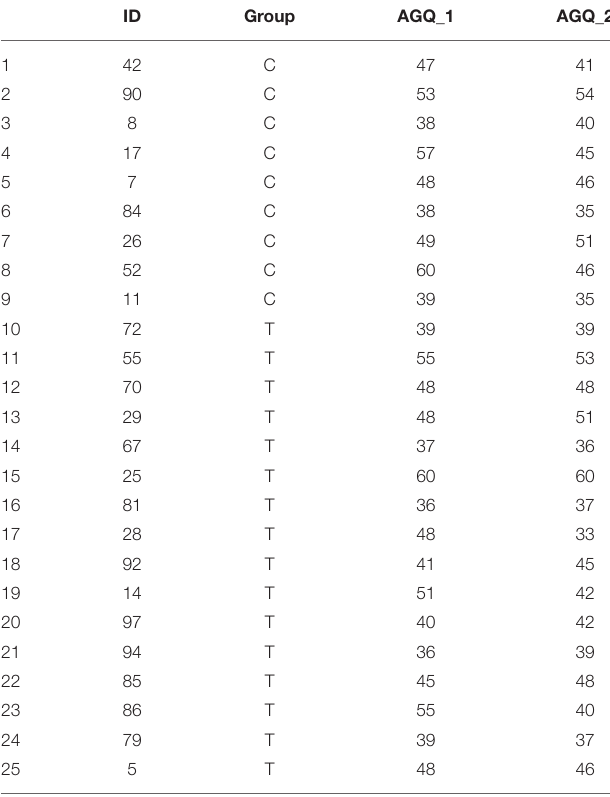
TABLE 4 | Responses to achievement goal questionnaire (AGQ) 15 weeks